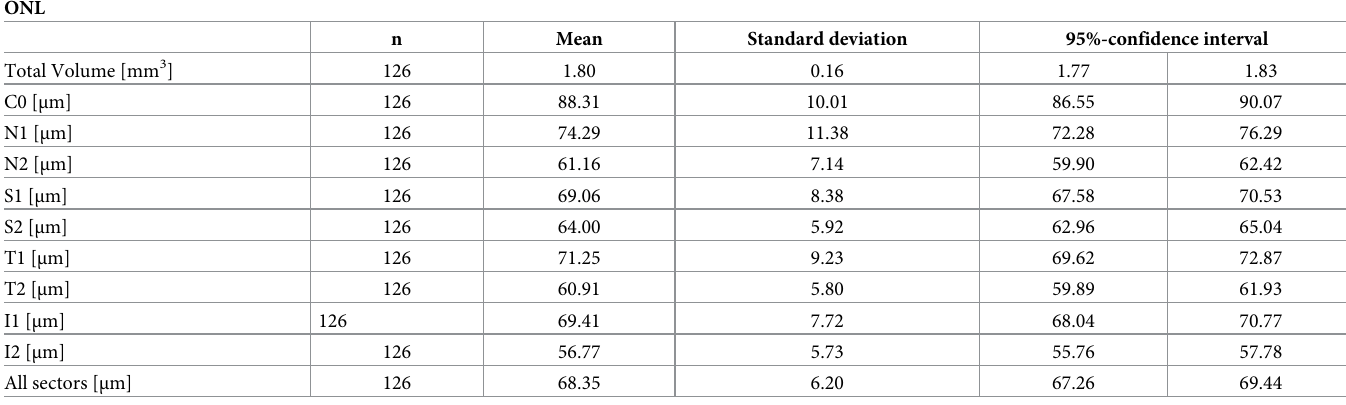
Table 11. ONL segmentation.